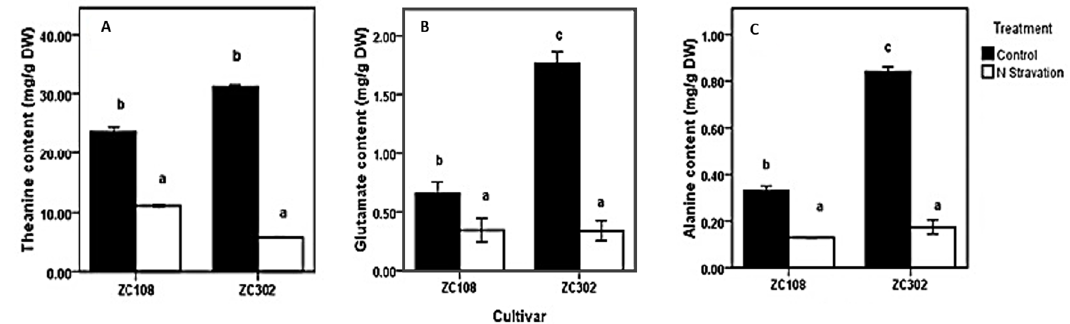
Figure 2. Effects of nitrogen starvation on content of amino acids involved in theanine biosynthetic pathway ( A – C ) in the root of tea plants. ZC108 refers to tea cultivar “Zhongcha 108”, and ZC302 refers to tea cultivar “Zhongcha 302”. Error bars represent the standard errors across three biological replicates. Different letters above the bars indicate significant differences at p < 0.05.